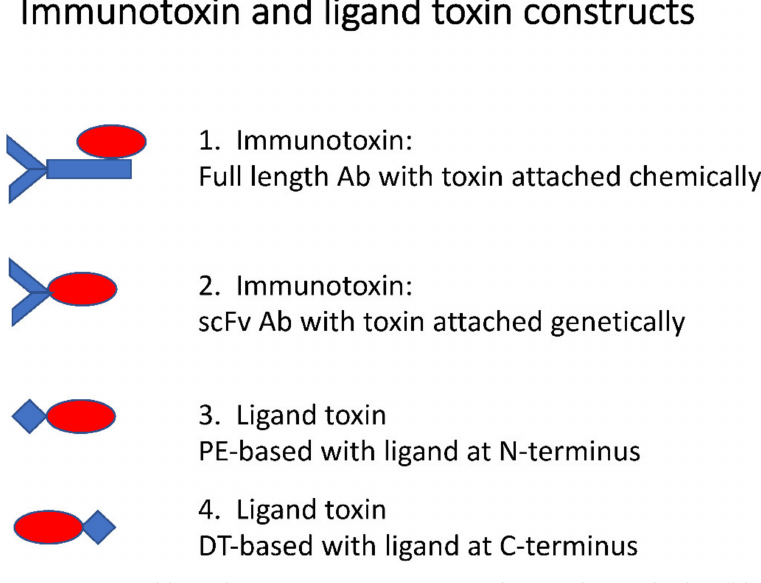
Figure 1. Immunotoxin and ligand toxin constructs. In examples 1 and 2, antibodies (blue) are joined with toxins (red) to form immunotoxins. Shown in example 1, a toxin is attached chemically to a full-length antibody. Example 2 is a genetic fusion between the single-chain Fv portion of an antibody and a toxin. In examples 3 and 4, the two most common ligand toxin constructs are shown. Example 3 shows a ligand toxin whereby the ligand (blue) is placed at the N -terminus of the construct, in place of pseudomonas exotoxin’s (PE’s) native binding domain. Example 4 shows the ligand at the C -terminus, replacing the native binding domain of diphtheria toxin (DT).